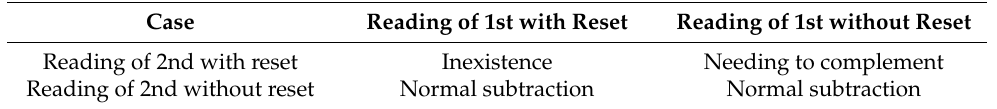
Table 3. The actual value of the phase